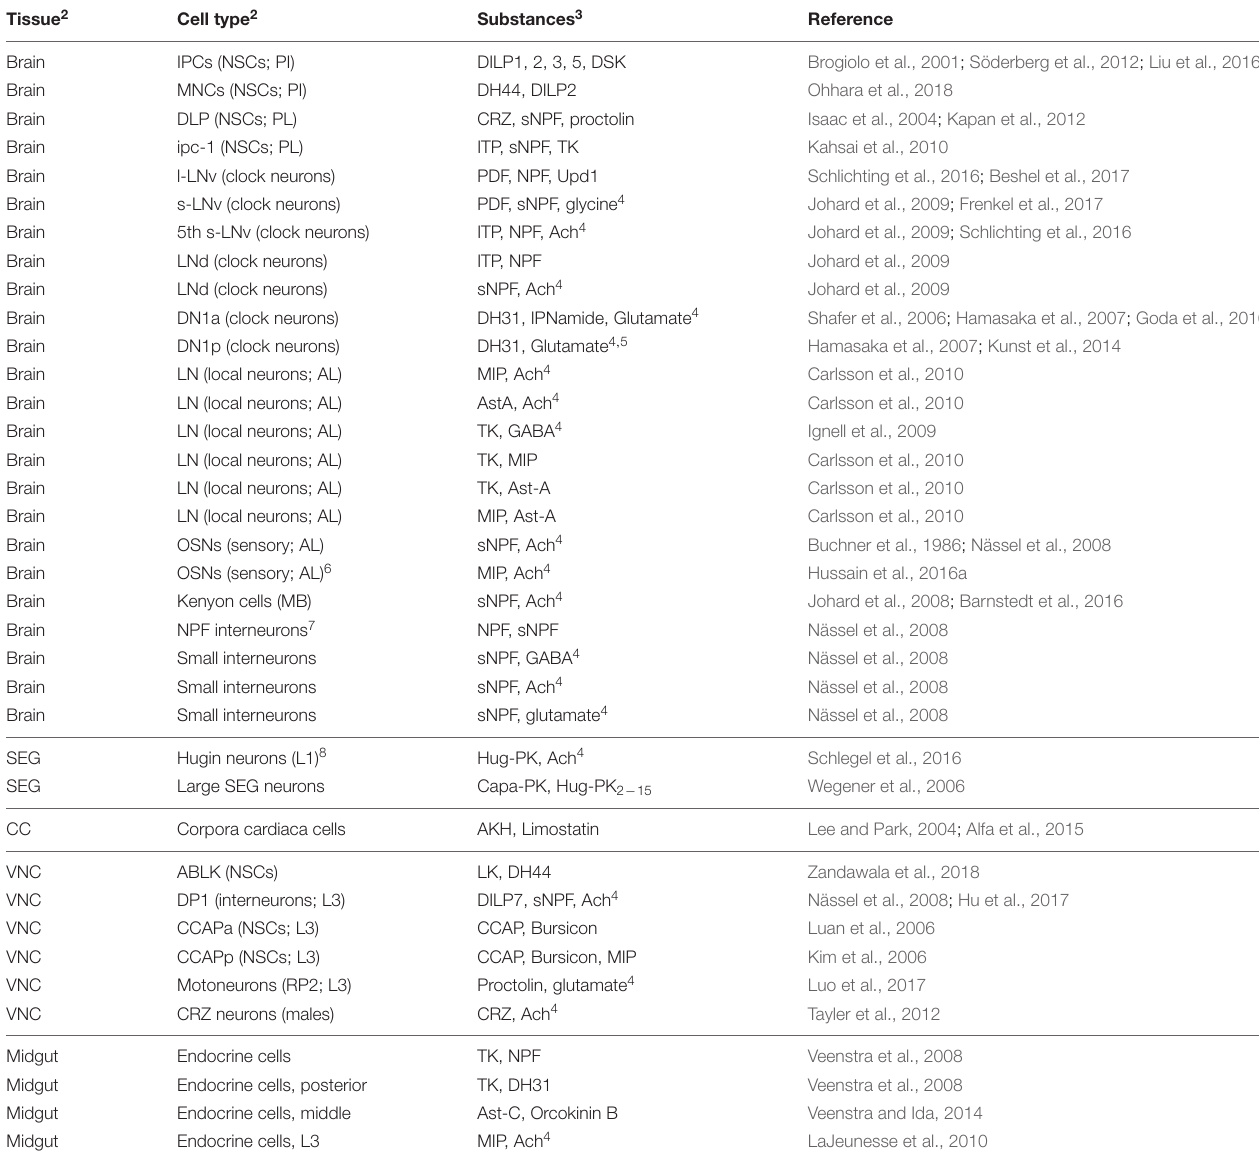
TABLE 2 | Colocalization of neuropeptides with neuropeptides and other neuroactive substances in neurons and endocrine cells of Drosophila established by marker techniques 1 . Tissue 2